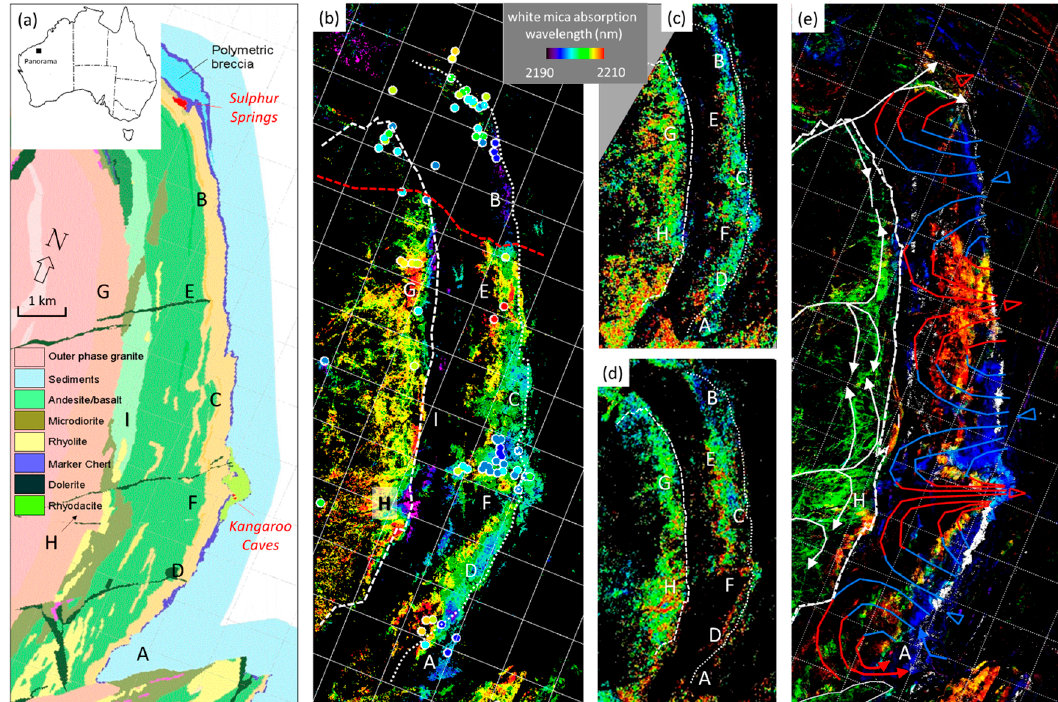
Figure 7. Airborne and satellite mineral mapping results for the Archaean Panorama volcanic massive sulfide, Pilbara, Western Australia. Scene center approximately − 21.1980° latitude 119.2216° longitude. ( a ) Published geology [75]; ( b ) Airborne HyMap™ (from 1998) image of white mica composition based on the wavelength minimum of the continuum-removed 2200 nm absorption (~Tschermak substitution). Similarly processed field data are embedded. Upper and lower boundaries of the volcanic pile are shown; ( c ) Satellite Hyperion (from 2001) of white mica composition based on the wavelength minimum (first derivative of a fourth-order polynomial fit) of the continuum-removed 2200 nm absorption (~Tschermak substitution); ( d ) Satellite ASTER image (from 2001) of Al-clay composition based on the index B 5 /B 7 and masked using (B 5 + B 7 )B6 >2; ( e ) Airborne HyMap™ image based on partial unmixing (RGB) of three white mica rich image endmembers overlaid with a threshold partially unmixed chert endmember product (white) and interpreted magmatic (white) seawater (blue to red) fluid flow lines.